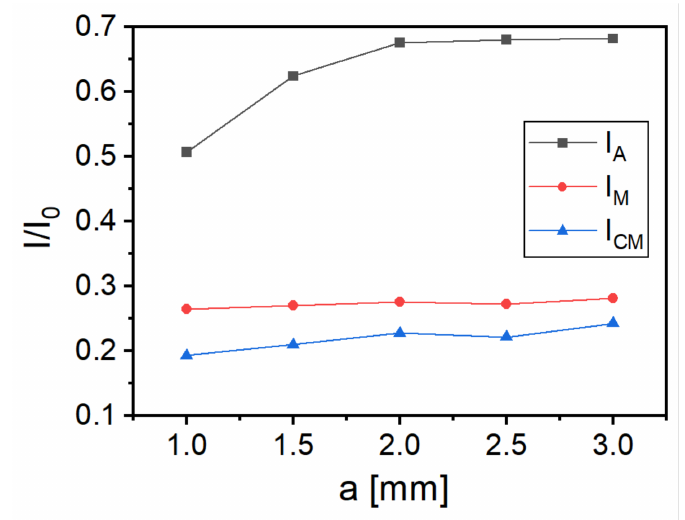
Figure 12. Normalized current as a function of Einzel lens size: I A —normalized anode current ( I A / I 0 ), I M —normalized membrane current ( I M / I 0 ), I CM —normalized current at the center of the membrane ( I CM / I M ).